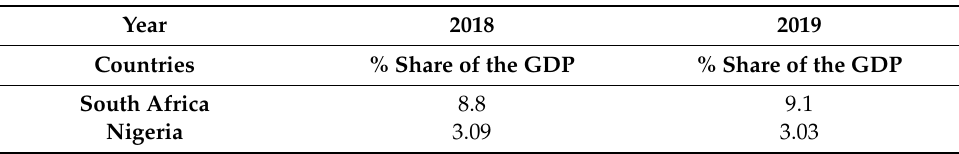
Table 1. Health expenditure as a share of GDP in South Africa and Nigeria (before and after COVID- 19 outbreak).